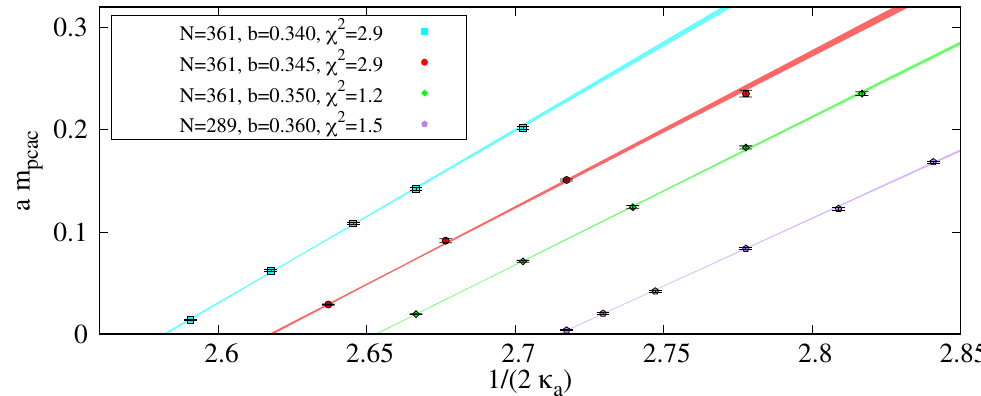
a ) for all the values of the , with the a